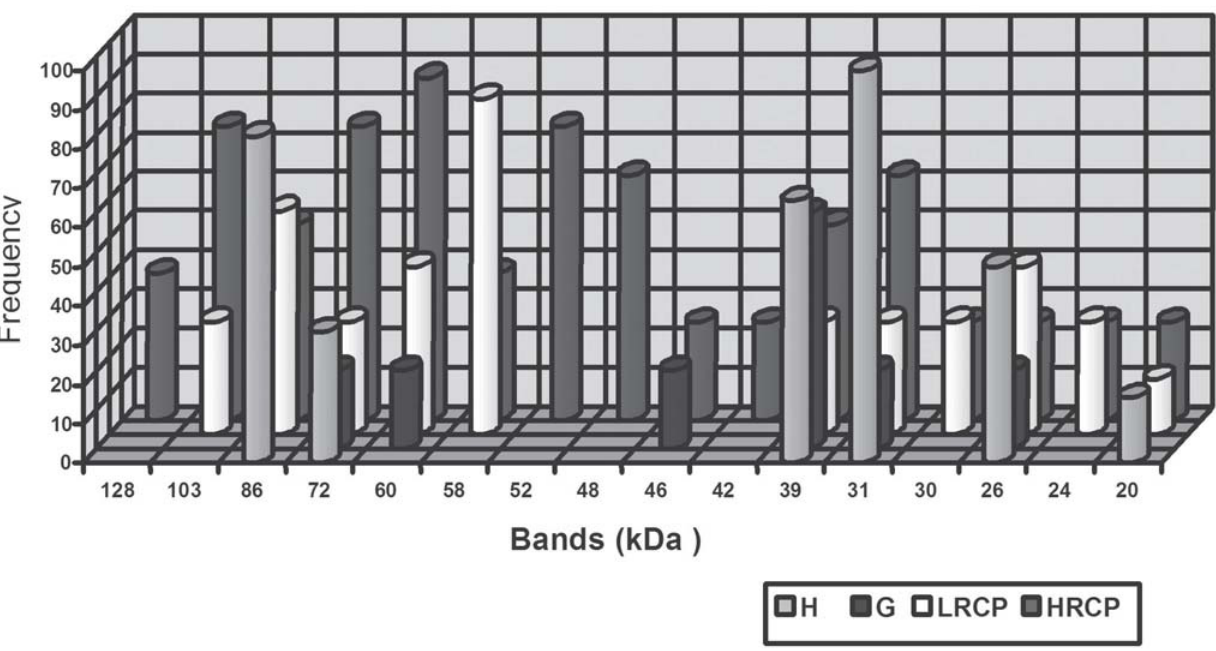
FIGURE 5- Band recognition frequencies in each individual group - healthy periodontium (H), gingivitis (G), low-response chronic periodontitis (LRCP) and high-response chronic periodontitis